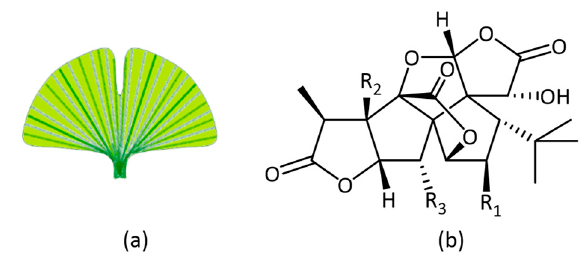
F igure 18. ( a ) Ginkgo leaf ( b ) ginkgolides. Figure 18. ( a ) Ginkgo leaf ( b )